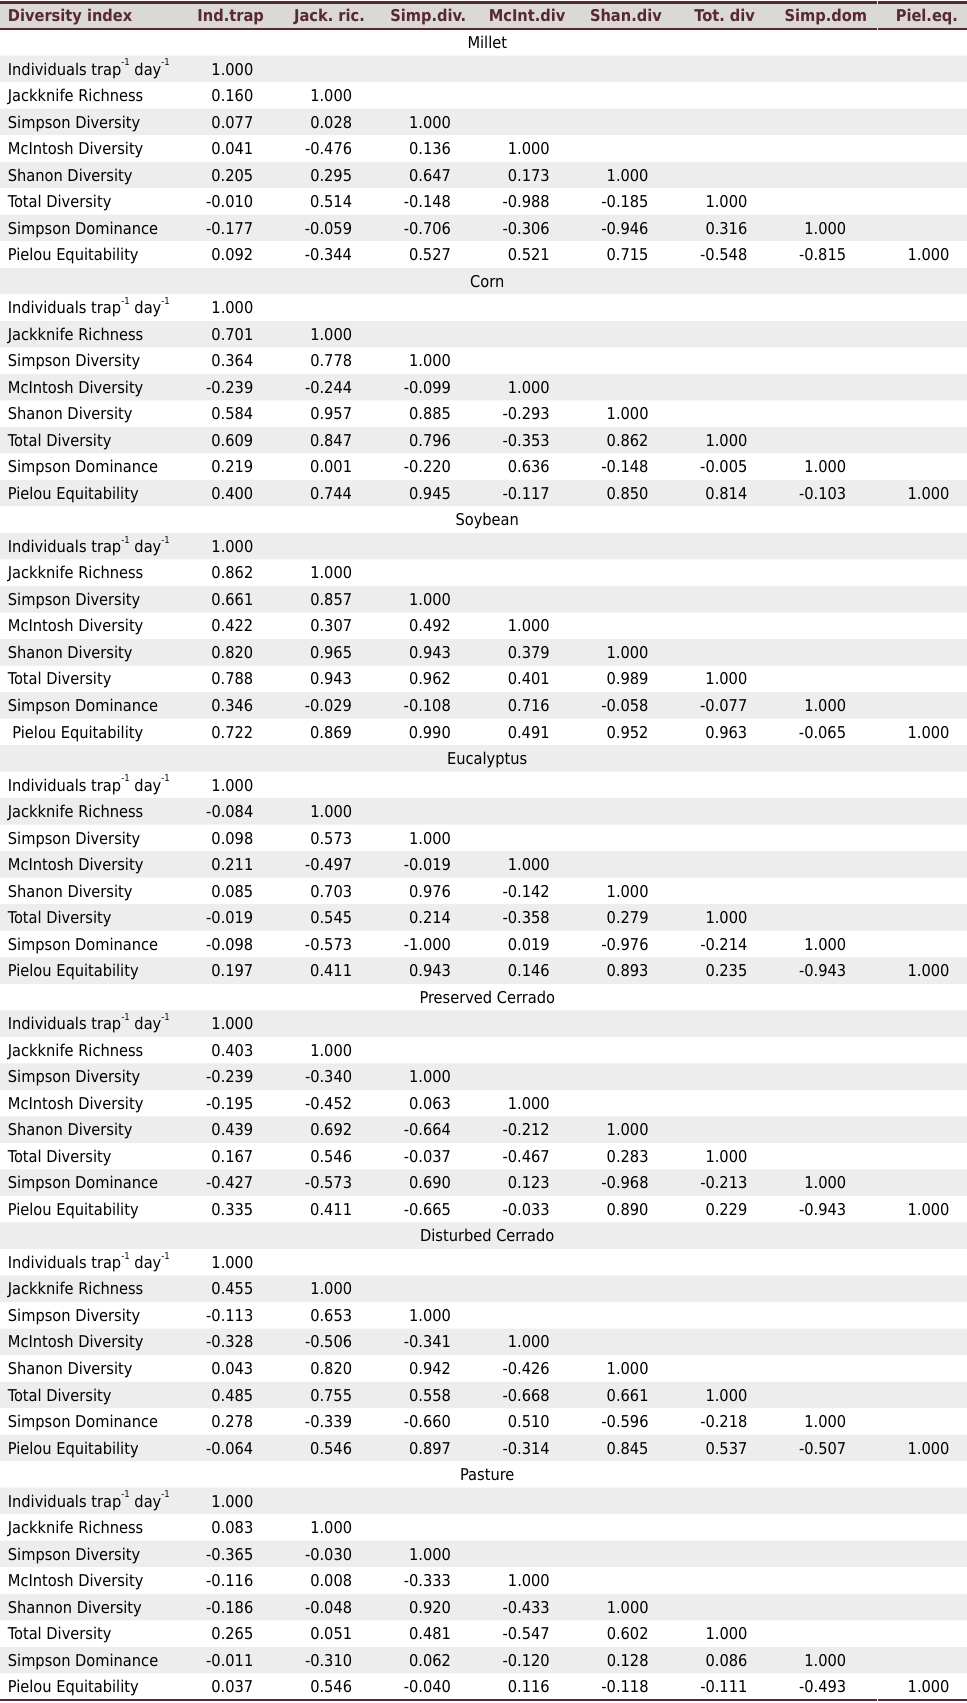
Table 5. Linear correlation matrix for the biodiversity indexes in the studied areas Diversity index Ind.trap Jack. ric. Simp.div. McInt.div Shan.div Tot. div Simp.dom Piel.eq. Millet Individuals trap -1 day -1